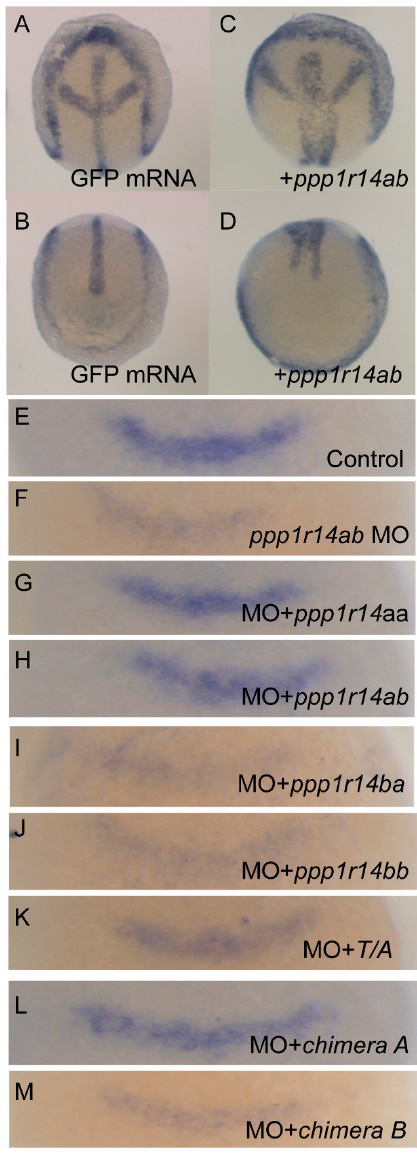
Figure 10. Expression of Cpi-17 paralogs, but not Phi-1 paralogs, can rescue ppp1r14ab loss-of-function. Embryos at bud stage stained with hgg1 (prechordal plate), shh (midline), pax2.1 (midbrain-hindbrain boundary), and dlx3 (neural plate) after injection of 200 pg GFP ( A and B ) or 200 pg ppp1r14aa mRNA ( C and D ). ( E - M ) embryos were collected at 10.5 hpf and stained with fgf3 after injection of 4ng of control MO ( E ), 4 ng of ppp1r14ab MO ( F ), 50pg of ppp1r14aa mRNA + 4 ng of ppp1r14ab MO ( G ), 50pg of ppp1r14ab mRNA + 4 ng of ppp1r14ab MO ( H ), 50pg of ppp1r14bb mRNA + 4 ng of ppp1r14ab MO ( I ), 50pg of ppp1r14aa mRNA + 4 ng of ppp1r14ab MO ( J ), 50pg of ppp1r14aa T38A mRNA + 4 ng of ppp1r14ab MO ( K ), 50 pg chimera A mRNA + 4 ng of ppp1r14ab MO ( L ), or 50ng chimera B mRNA 4 ng of ppp1r14ab MO ( M ).